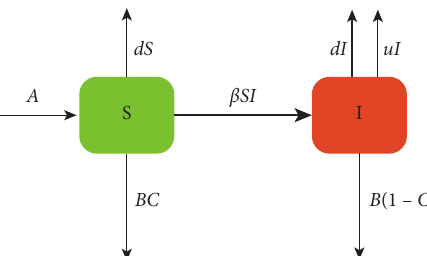
Figure 1: Flow diagram of disease transmission. Here, S denotes susceptible, I denotes infected, B is transport proportion, and C is the proportion of susceptible in the